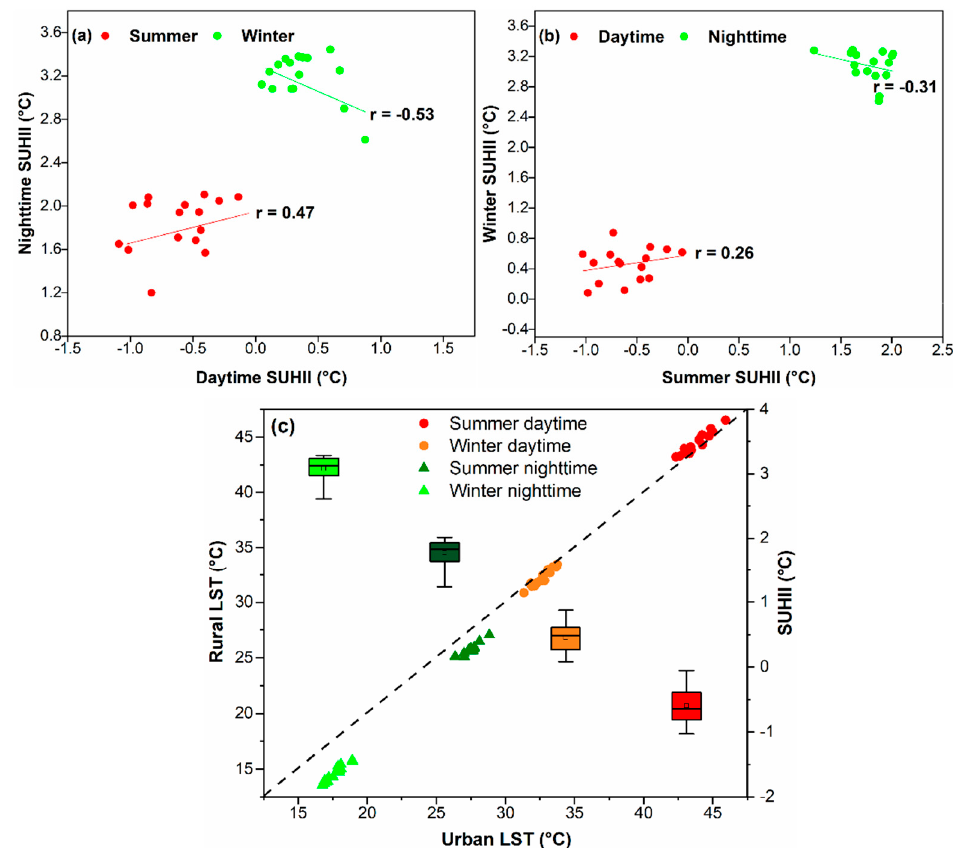
Figure 7. Correlations between day and night mean SUHII for the 16 years ( a ); between summer and winter SUHII ( b ); between urban LST, rural LST, and SUHIIs ( c ). In panel ( c ) the SUHII is represented by a boxplot.